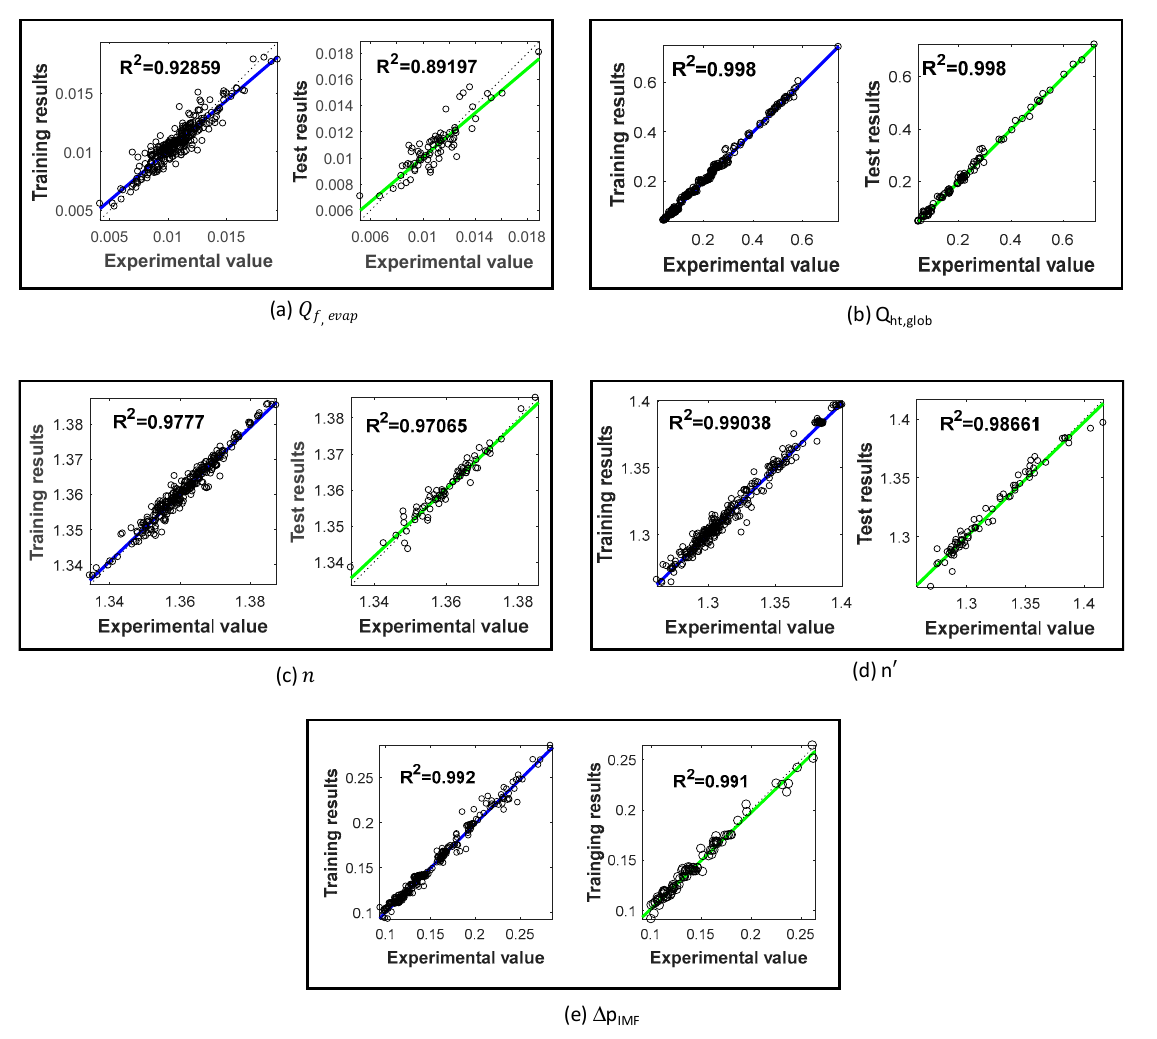
Figure A8. ( a – e ) Comparison of the experimental and ANN fitting results for the physics-based model parameters (pressure simulation).